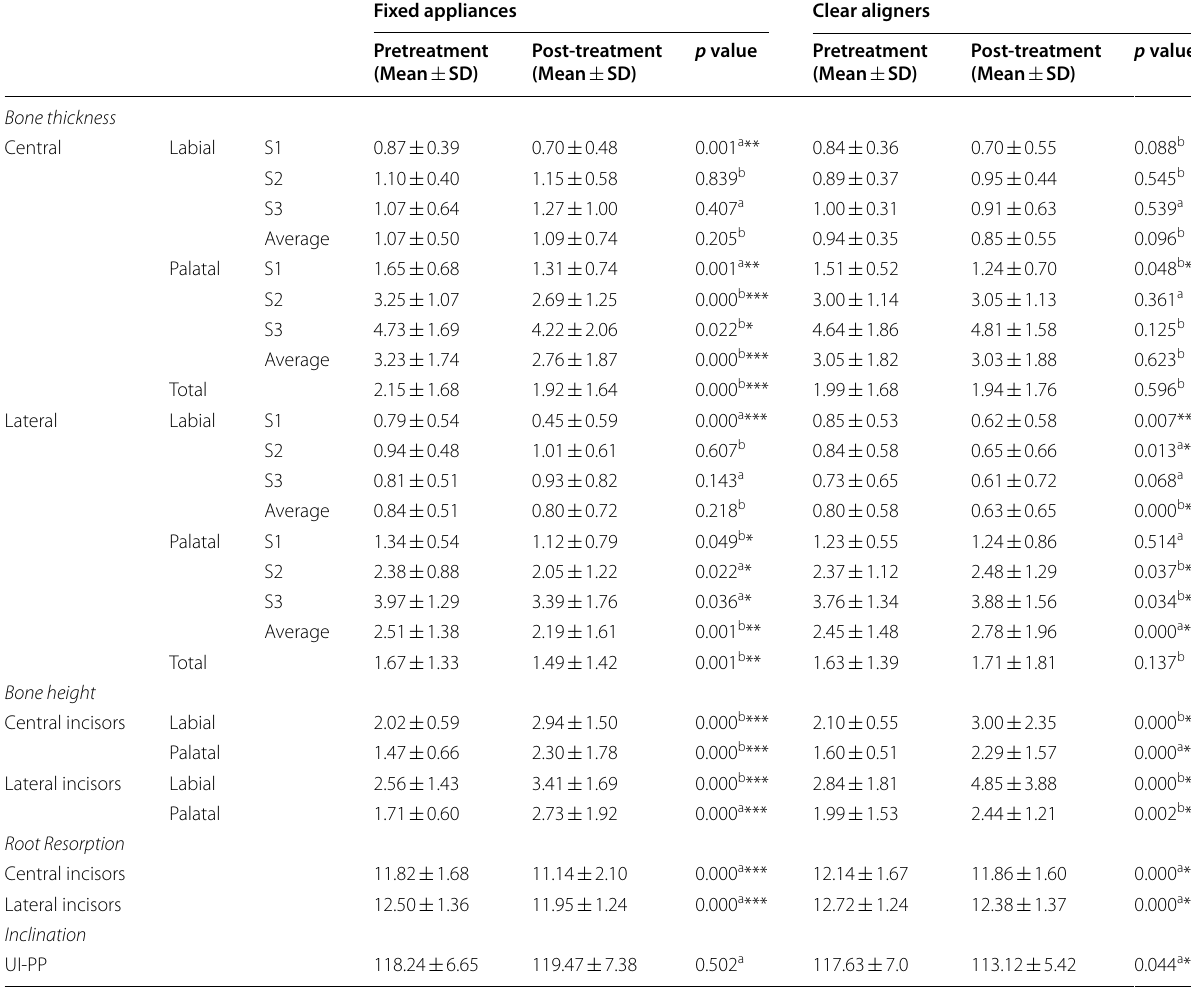
Table 3 Intra‑group comparison (T0‑T1) of the two studied